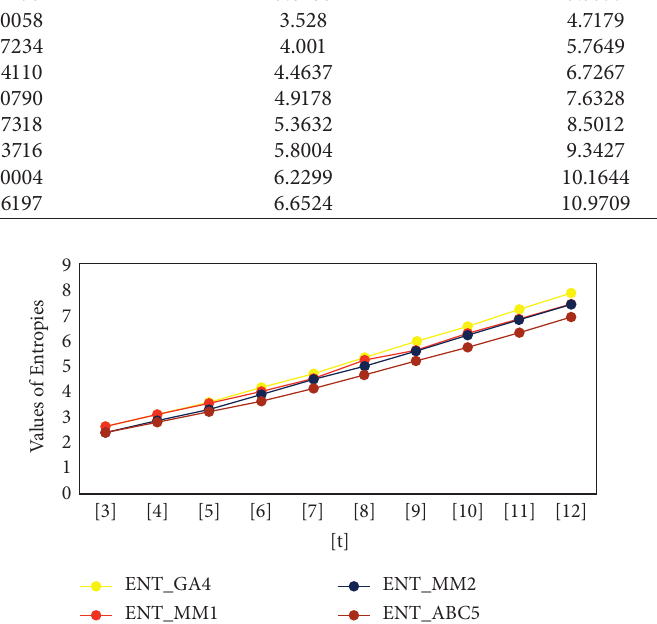
Figure 5: Graphical comparison of eccentricity-based entropies for hypertree CBT ( t ) .